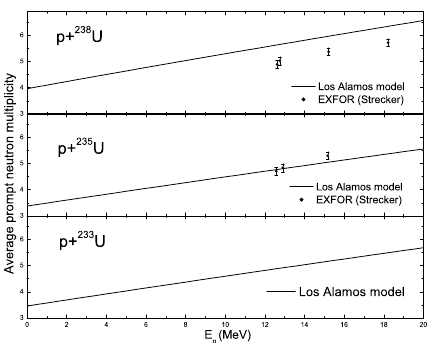
Fig. 3. Average prompt neutron multiplicity for p + 233 , 235 , 238 U ver- sus the incident proton energy and the experimental data.